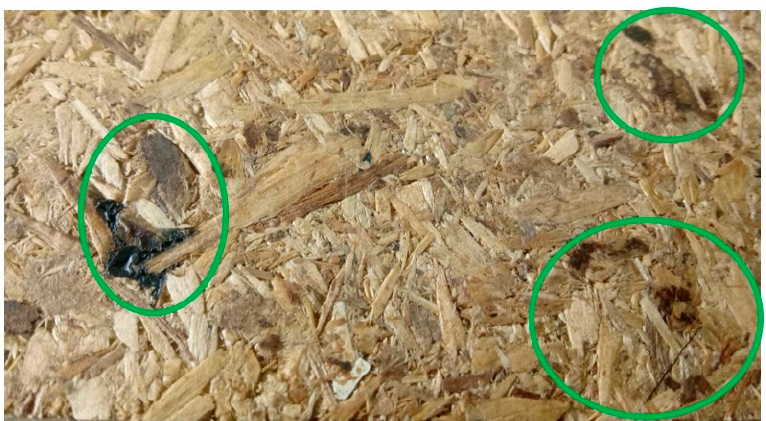
Figure 3. Dark brown spots on the surface of the panels with 50% BSG and 50% wood particles bonded with pMDI. Table 2. Results of the ANOVA with p -values and η 2 -values for the explanatory variables.